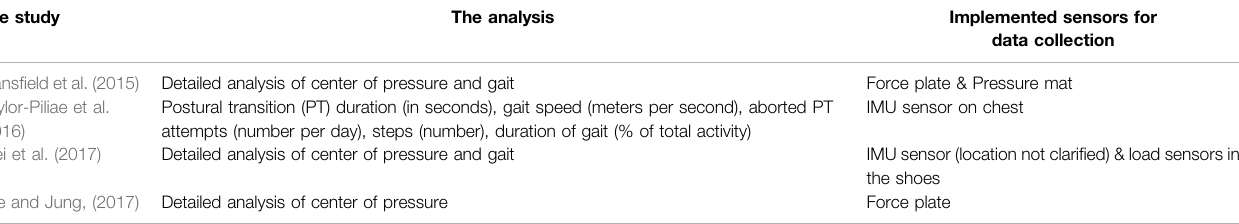
TABLE 5 | The articles conducted detailed balance and motion analysis and their implemented